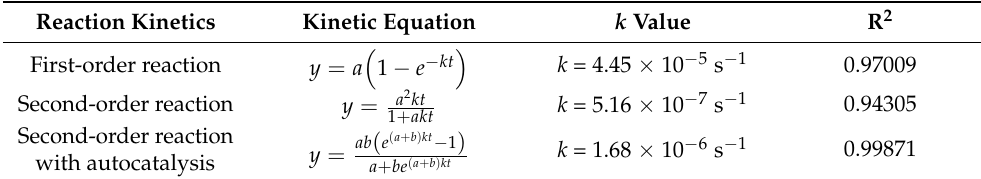
Figure 2. SEM images of the prepared samples with different synthesis times: ( a , d ) 3 h, ( b , e ) 6 h, ( c , f ) 12 h, ( g ) 24 h and ( h ) 48 h. ( i ) Fitting curves to the sample thickness. Red circles highlight the surface characteristics. Table 1. Summary of the kinetic fitting to the sample